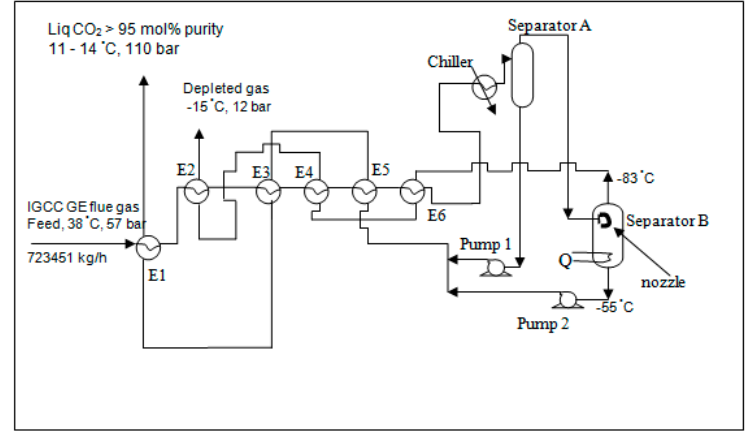
Figure 6. Energy saving scheme for CO 2 capture from a 740 MW IGCC GE power plant.